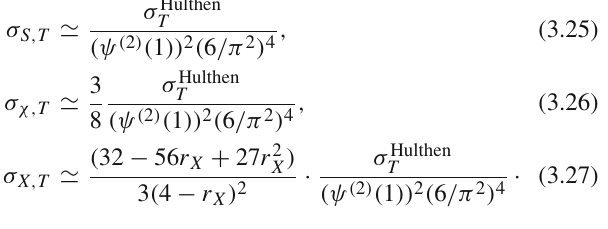
Fig. 1 Contours of dark matter self-scattering cross sections in m G vs m DM , depending on the spins of dark matter, s = 1 / 2 , 0 on left and right. We have chosen A DM = 1 and the DM velocity to the one at dwarf galaxies, v dwarf = 10 − 4 . The orange dashed and solid lines are the results for the Born cross section, whereas the purple and blue lines are those for the non-perturbative cross section. We took σ / m = 0 . 1 , 10cm 2 / g. The T DM case with s = 1 shows